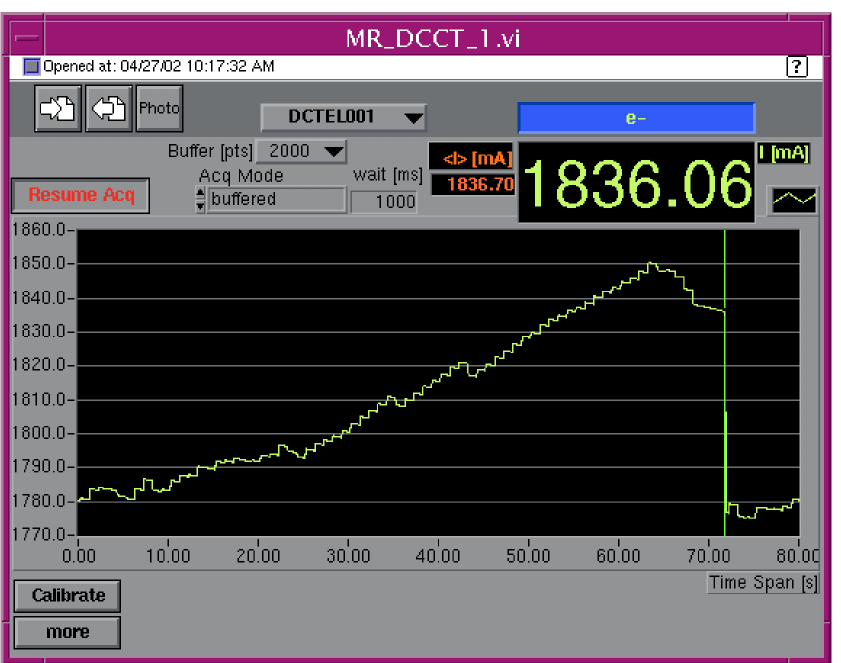
FIG. 13. (Color) The control system window showing the maximum current achieved with a stable e (cid:1) beam (1850 mA, 90 bunches, April 2002).